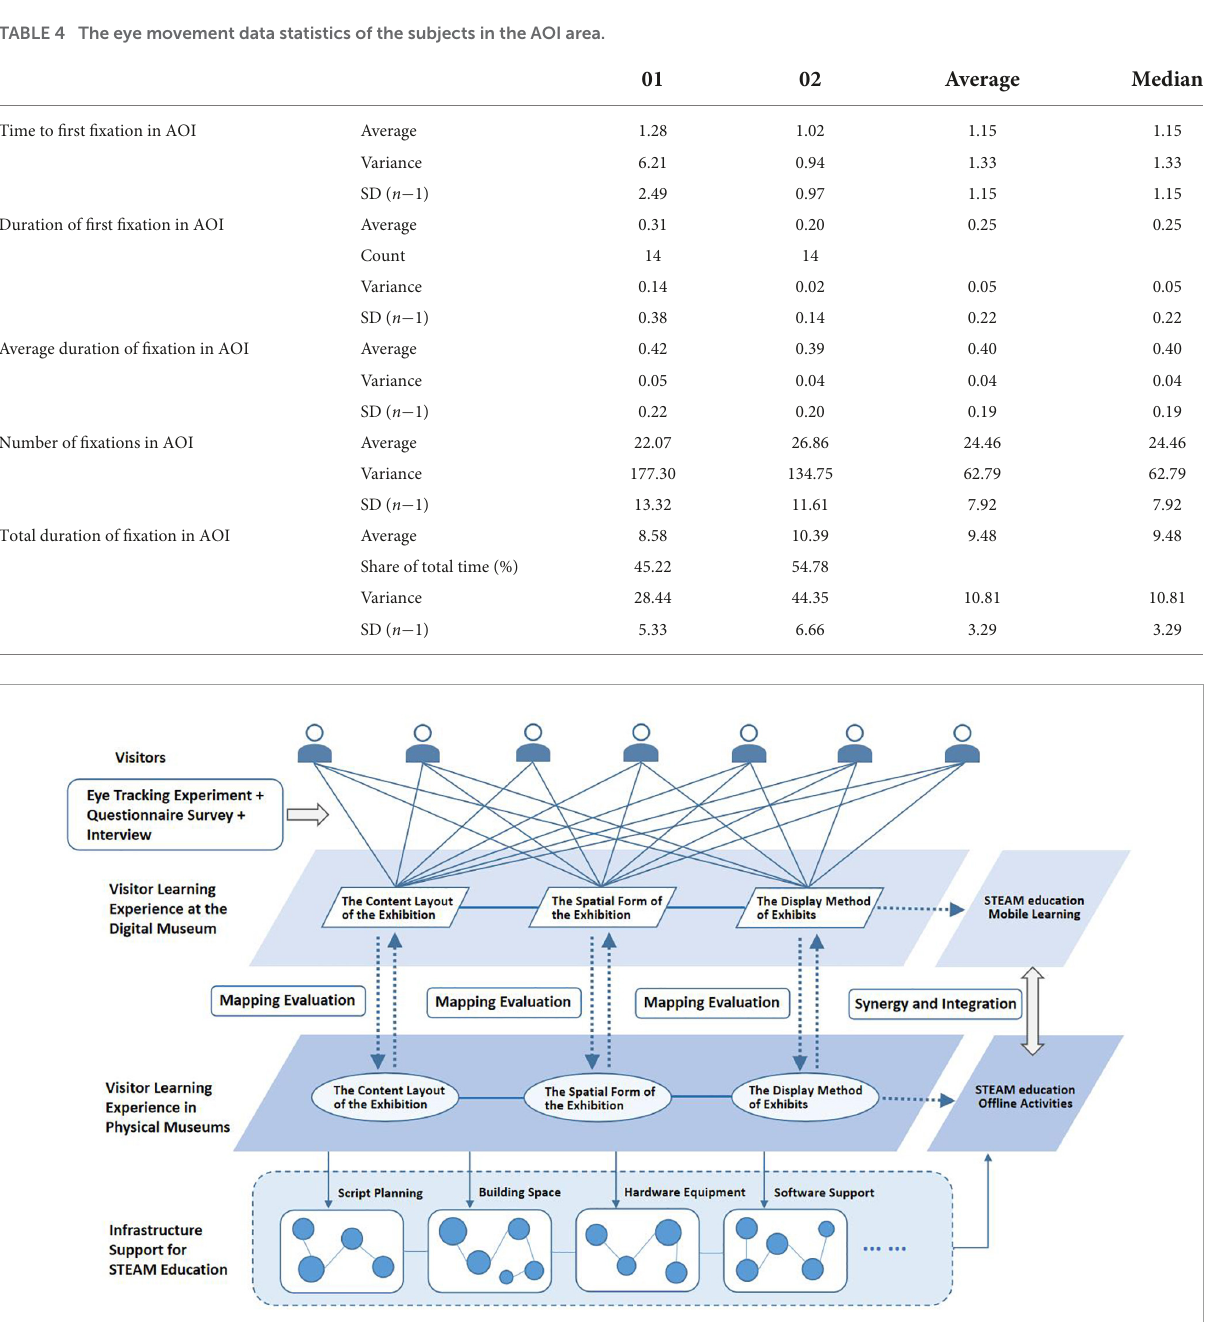
FIGURE12 Model diagram of multi-dimensional learning experience evaluation framework for visitors in digital